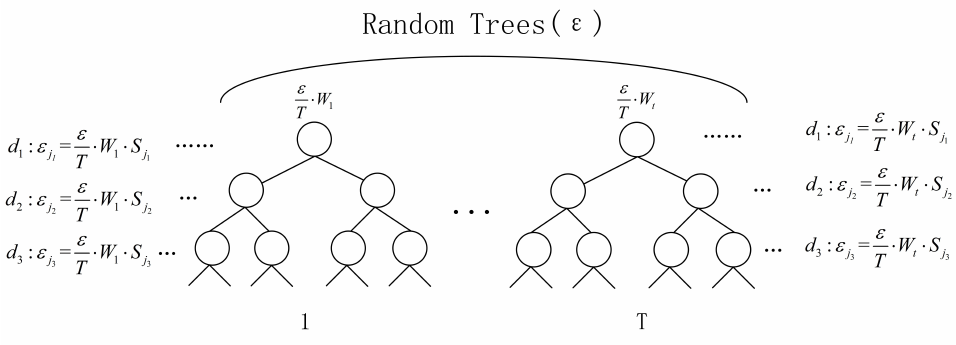
Figure 1. Overview of privacy protection budget